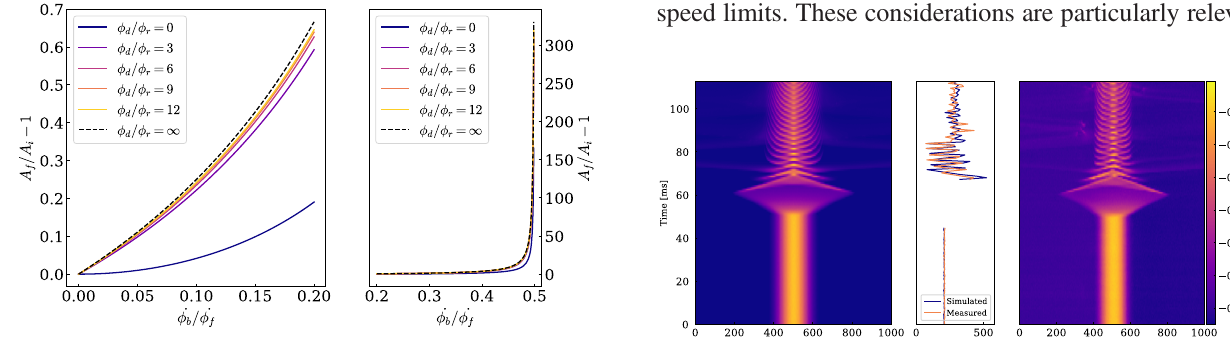
_ ϕ _ ϕ ≈ 0 . 25 . The = b f